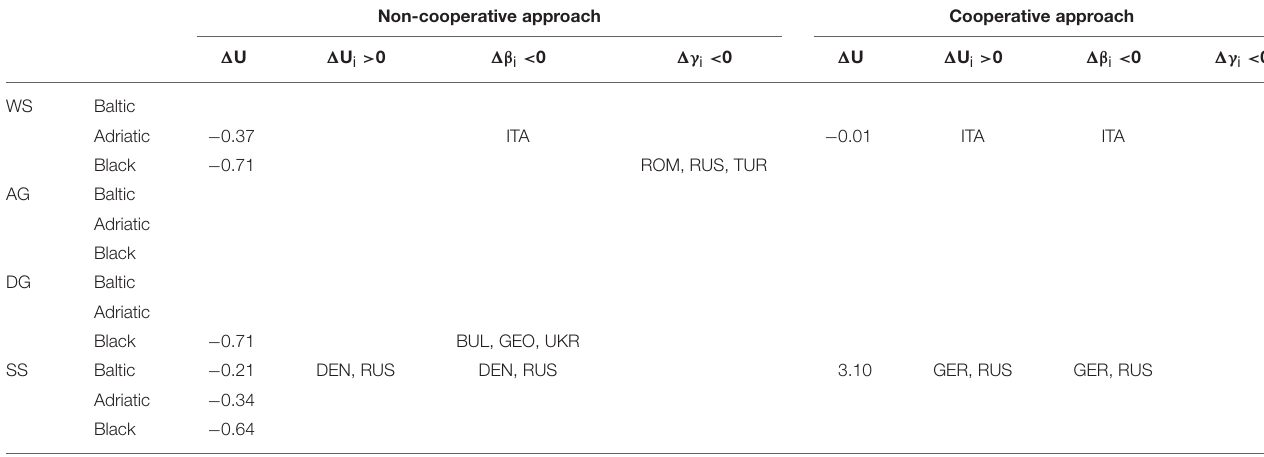
TABLE 12 | Challenging results: countries improving welfare (i.e., 1 Ui > 0); and countries expected to implement anti-environmental policies (i.e., 1 β i < 0 and 1 γ i < 0). Non-cooperative approach Cooperative